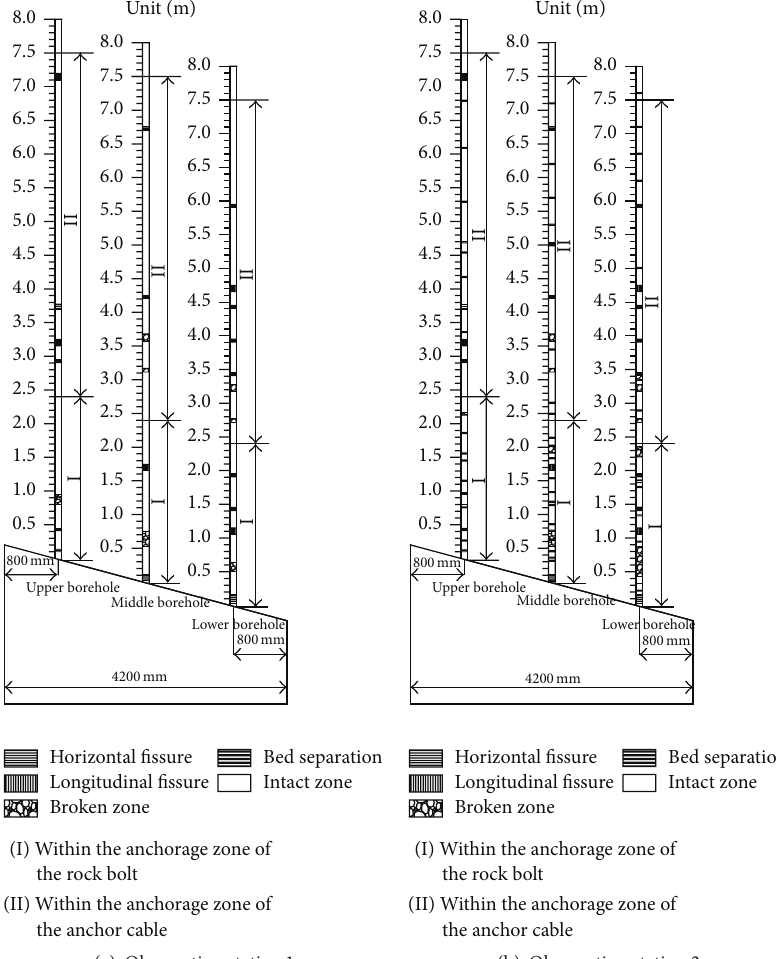
Figure 5: Collection of borehole imaging results and its